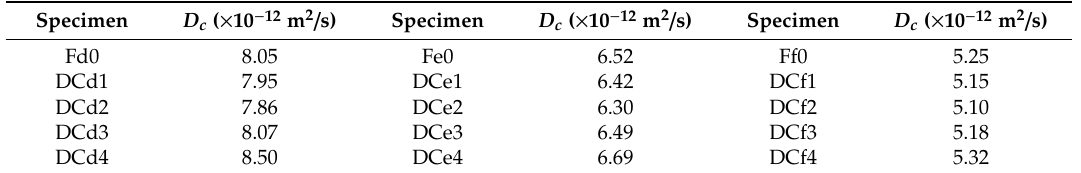
Table 5. Chloride di ff usion coe ffi cient under sustained uniaxial